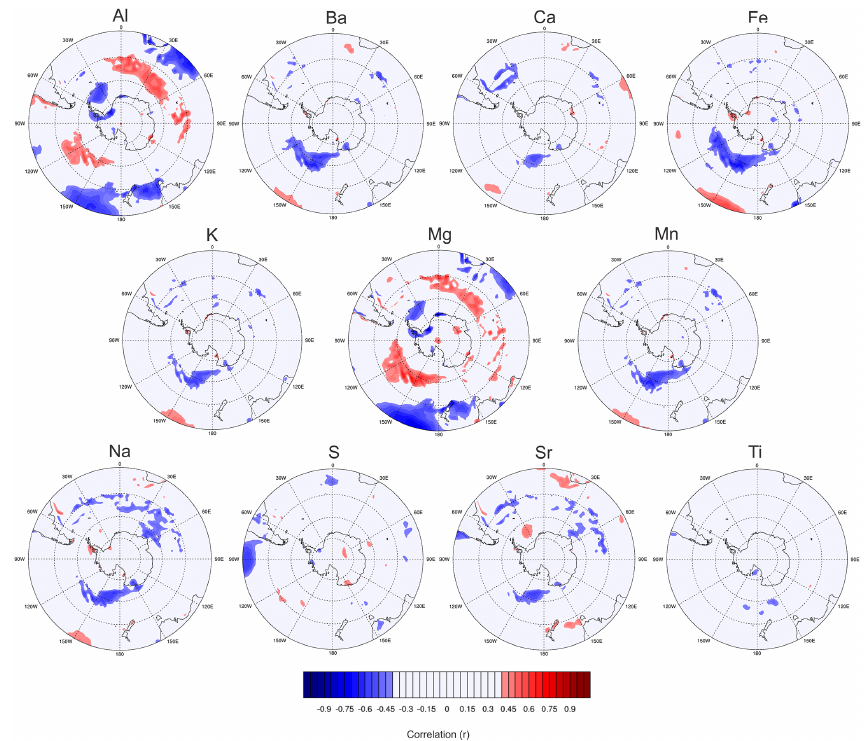
Figure 7. Correlation of the 1979–2008 ERA-Interim reanalysis 2m air temperature parameter with the annually averaged trace elements time series in the MJ ice